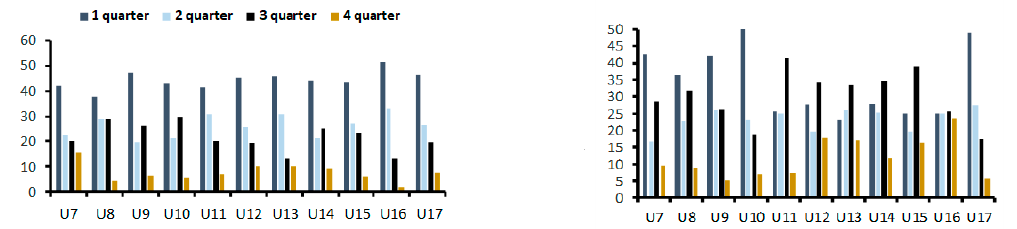
Figure 2. Relative age effect (RAE) by age group in top ( left ) and middle-tier soccer academies ( right ). U—indicates age group.